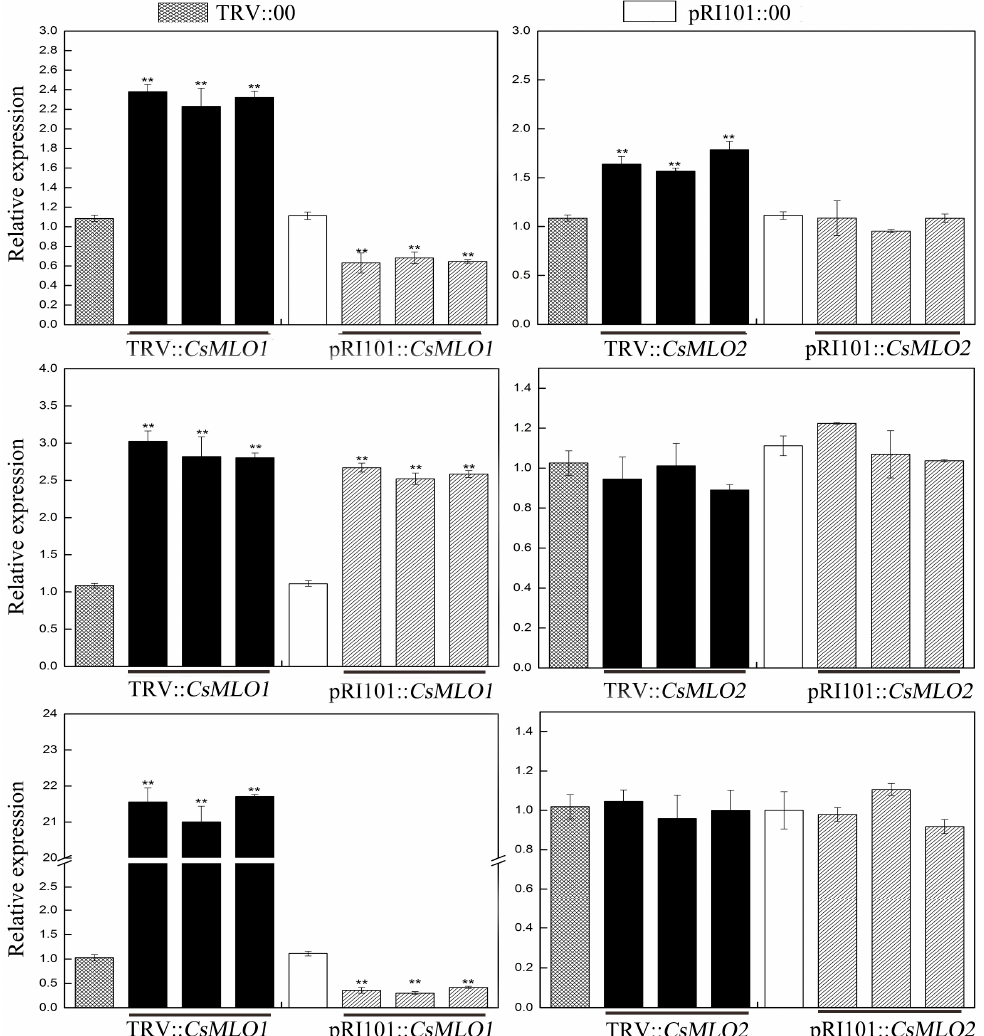
Figure 3. CsMLO1 -mediated expression patterns of CsCaM in cucumber cotyledons via RT-qPCR. Data are the means ± standard deviations from three biological experiments, and each column represents a sample containing three cucumber cotyledons from di ff erent plants. Expression analysis of the candidate genes using the 2 − ∆∆ Ct method. The asterisks indicate a significant di ff erence (Student’s t test, ** P < 0.01).